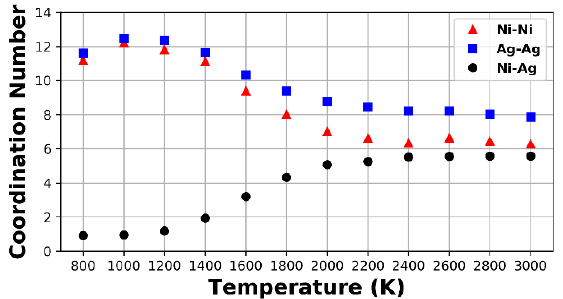
Figure 5. Coordination numbers for the bulk samples at different temperatures.